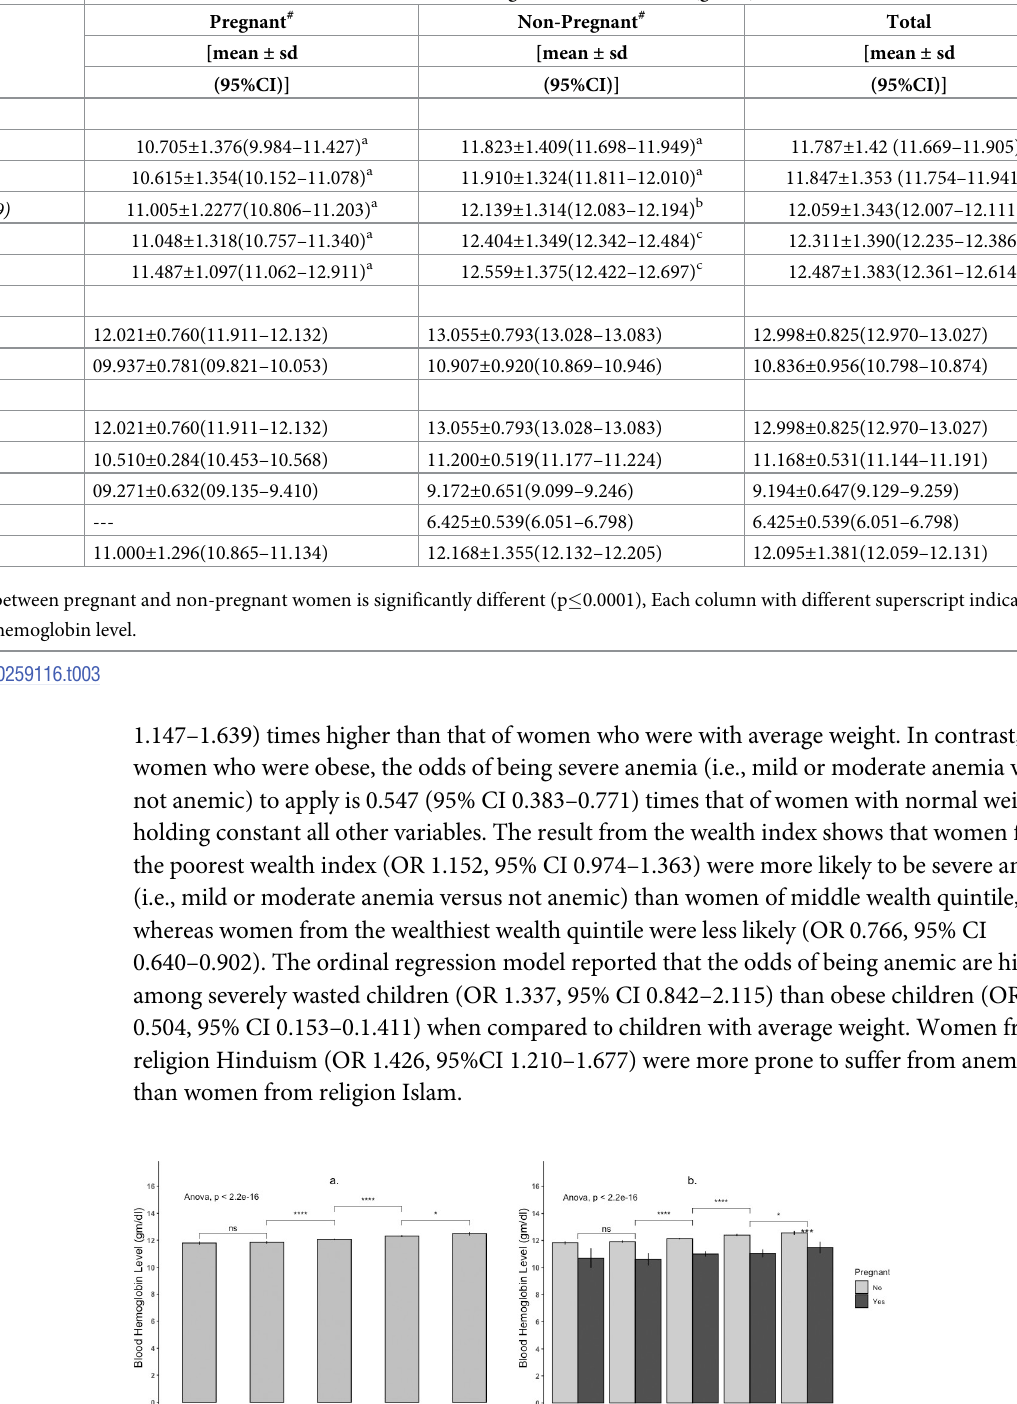
Table 3. Blood hemoglobin level of women (n = 5680) based on BMI category and pregnancy status.